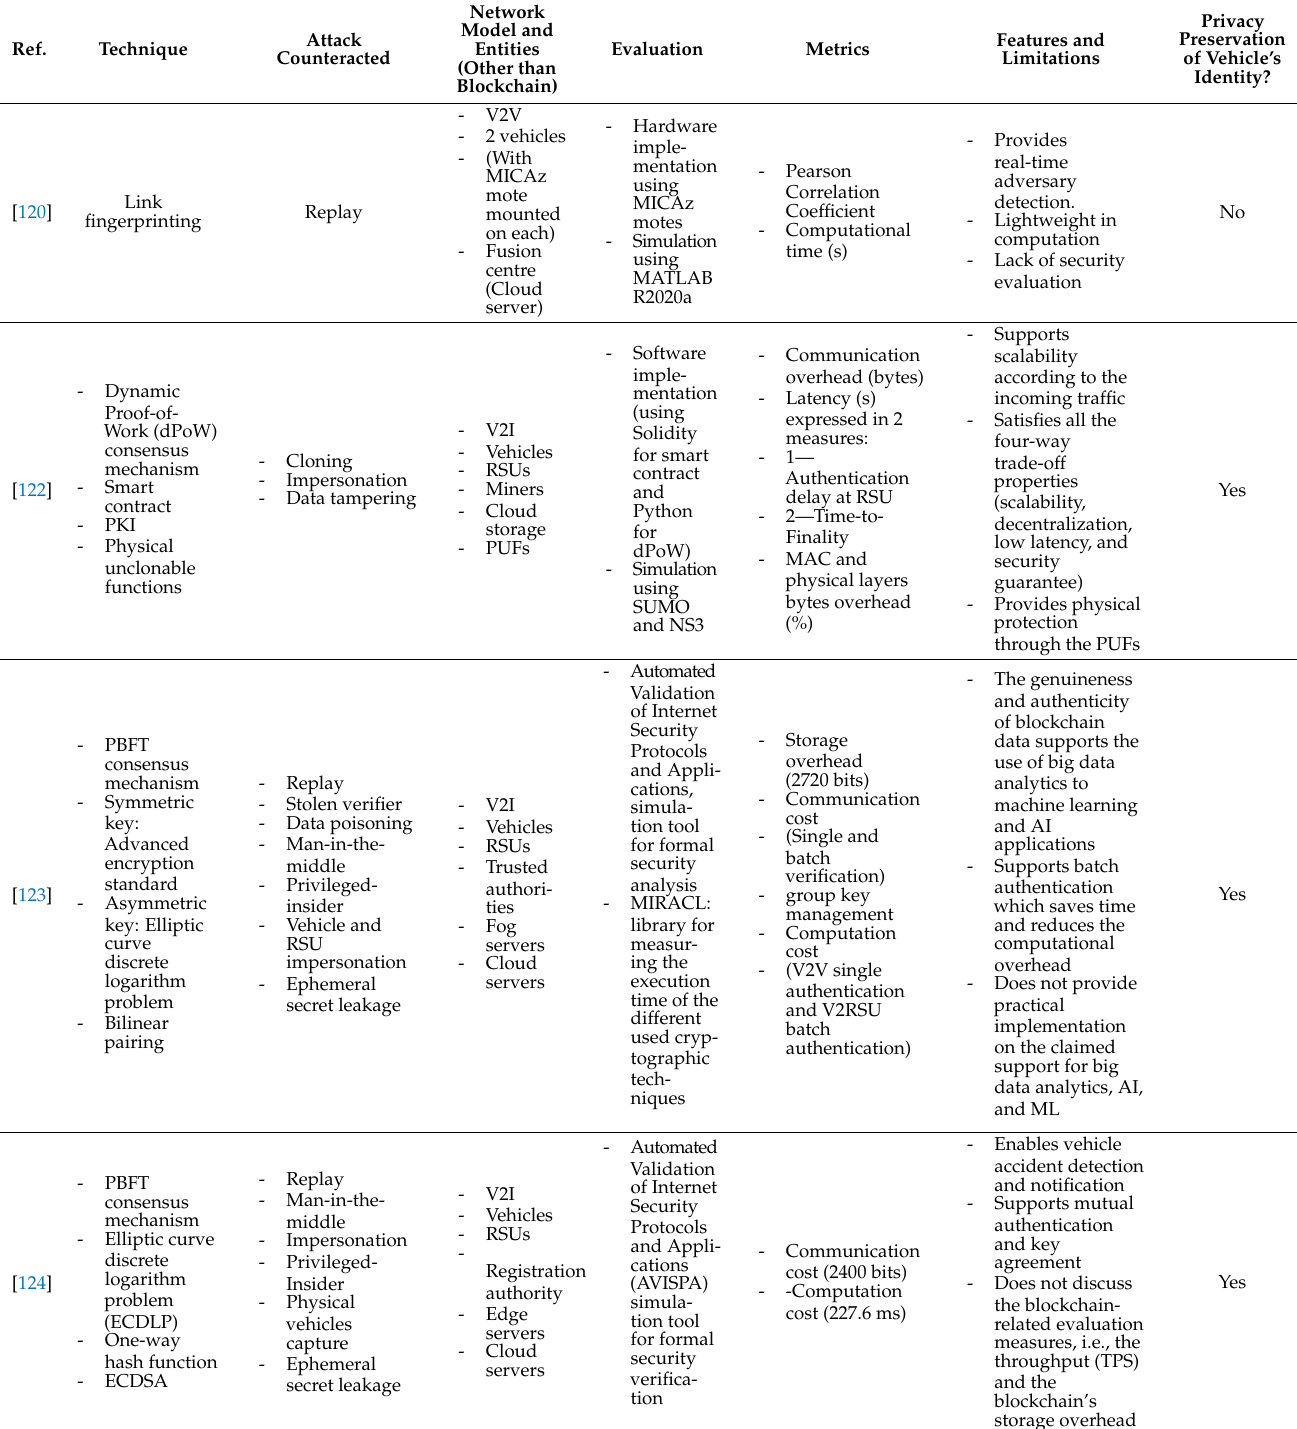
Table 5. A comparative study of the public blockchain-based authentication schemes in IoV and VANETs.